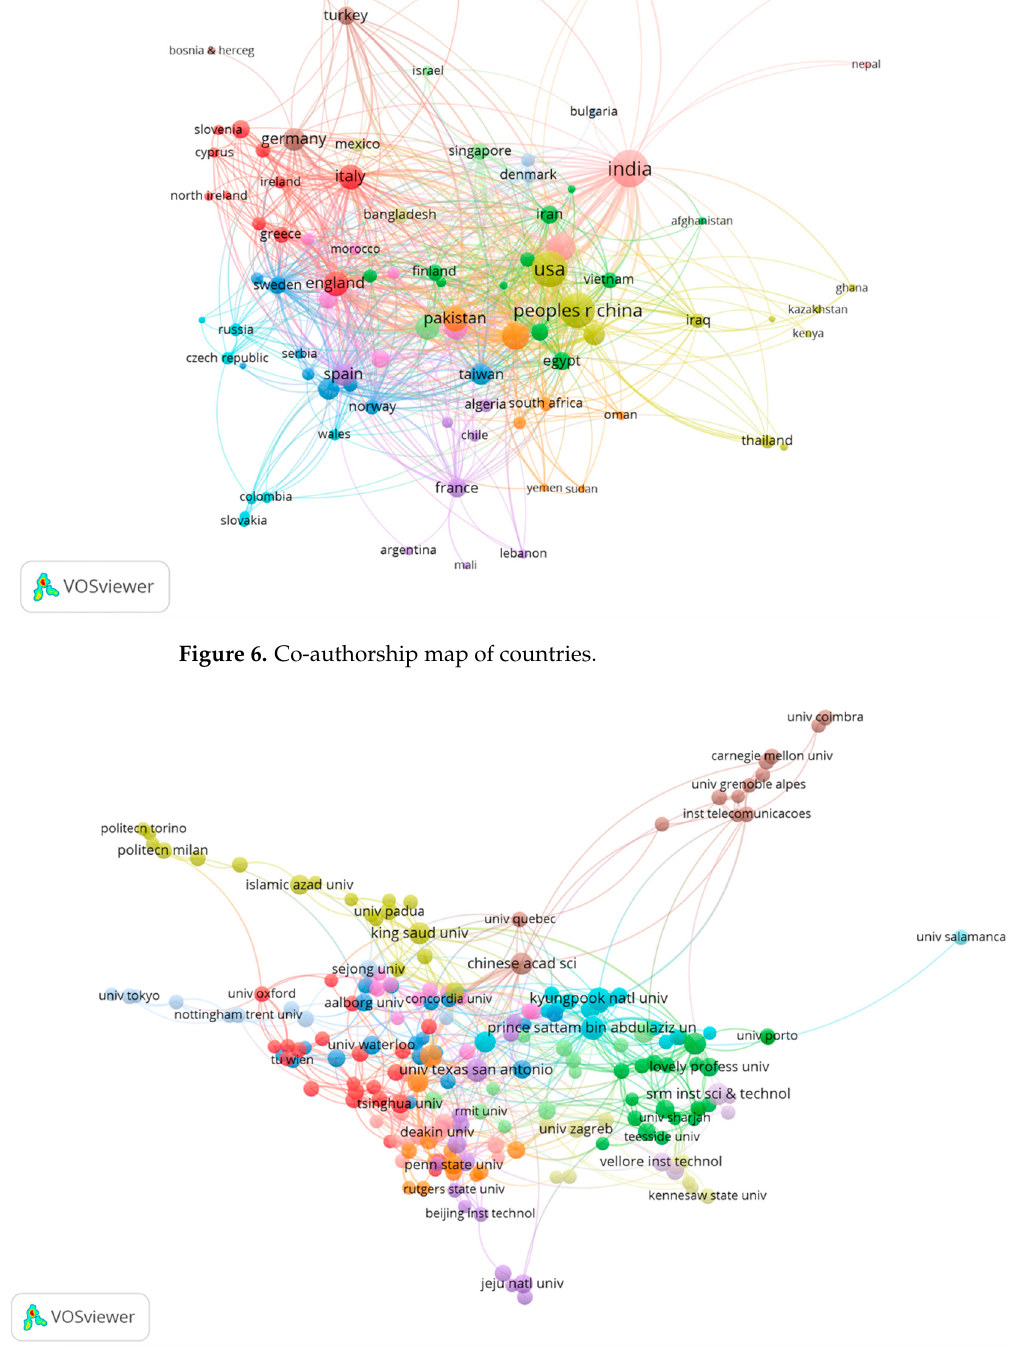
Figure 7. Co-authorship map of organizations.